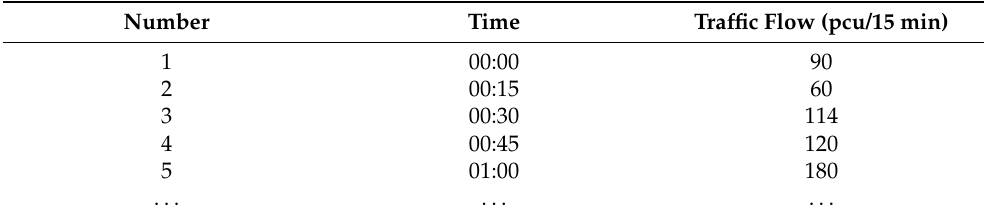
Table 4. Selected data from the traffic situational awareness dataset.